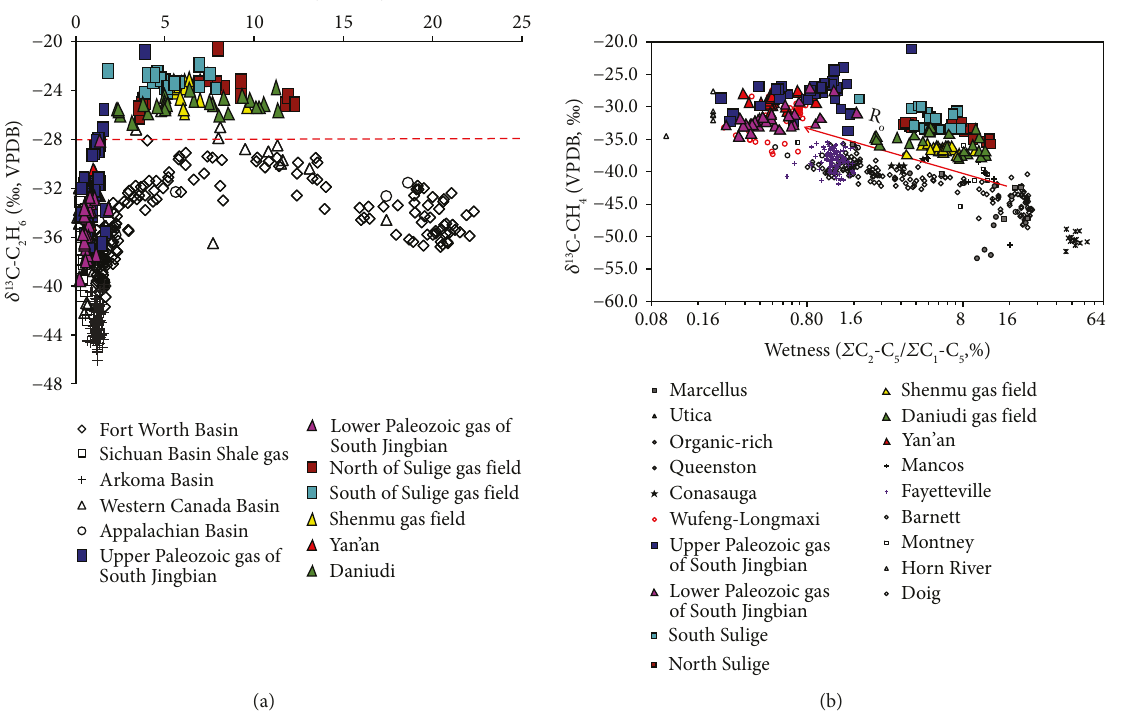
versus wetness (modi fi ed from [15]). (Data sources for shale gas 4